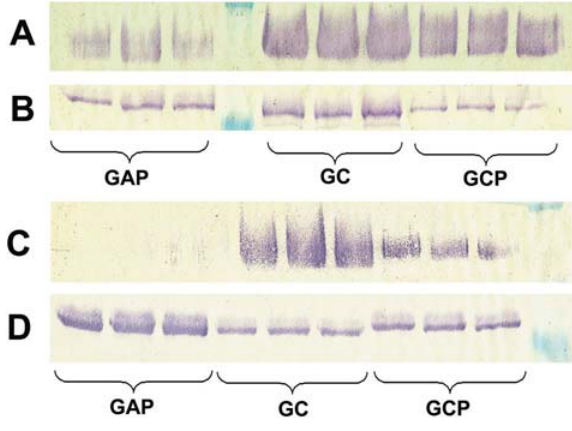
Figure 2- Comparison of glycoproteins expression under non-stimulated (A, B) or stimulated (C, D) conditions. A-MG2 Western blot; B-Lactoferrin Western blot; C-MG2 Western blot; D-Lactoferrin Western blot; APG- Aggressive periodontitis group; CPG-Generalized